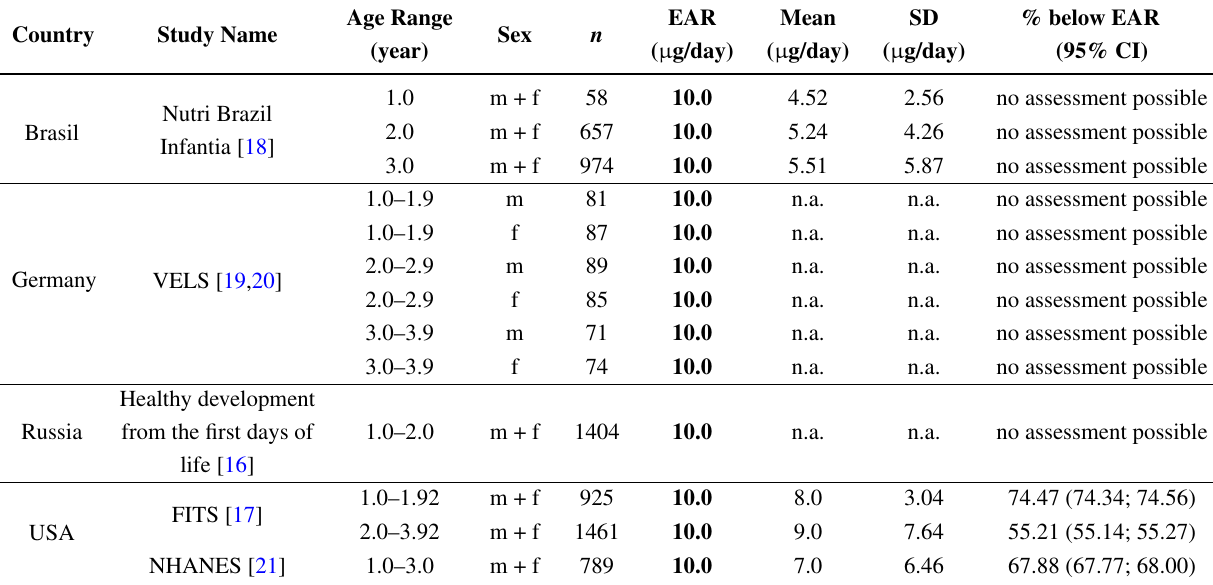
Table 5. Mean vitamin D intake ( µ g/day) and prevalence of inadequate intake (% below EAR) in Brazil, Germany, Russia and the United